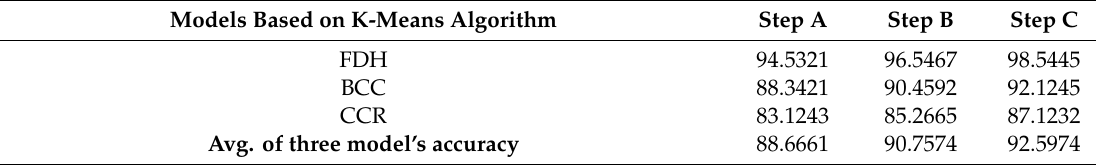
Table 14. Accuracy comparison contained by K-means algorithm (All Numbers Are in Percent). Models Based on K-Means Algorithm